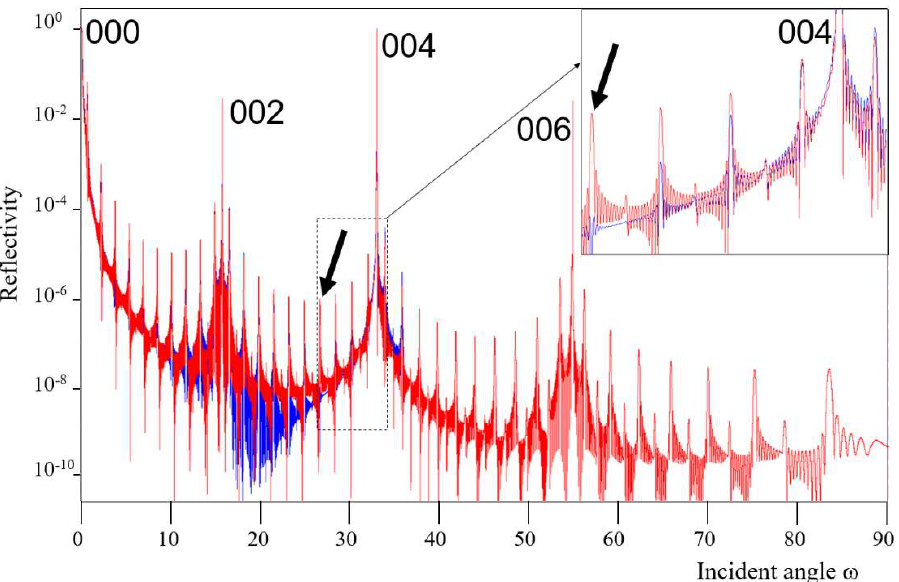
Figure 2. The simulation of the full diffraction profile (red) using the Fresnel theory compared with the 3-beam dynamical theory (000, 002 004 reflections, blue). The 3-beam dynamical theory simulation now includes the 004 peak (as well as the 000 and 002), and the profile has become closer to the more complete theory; however, there are still differences that are still clear around the 004 reflection (arrowed) because the 006 is not included.